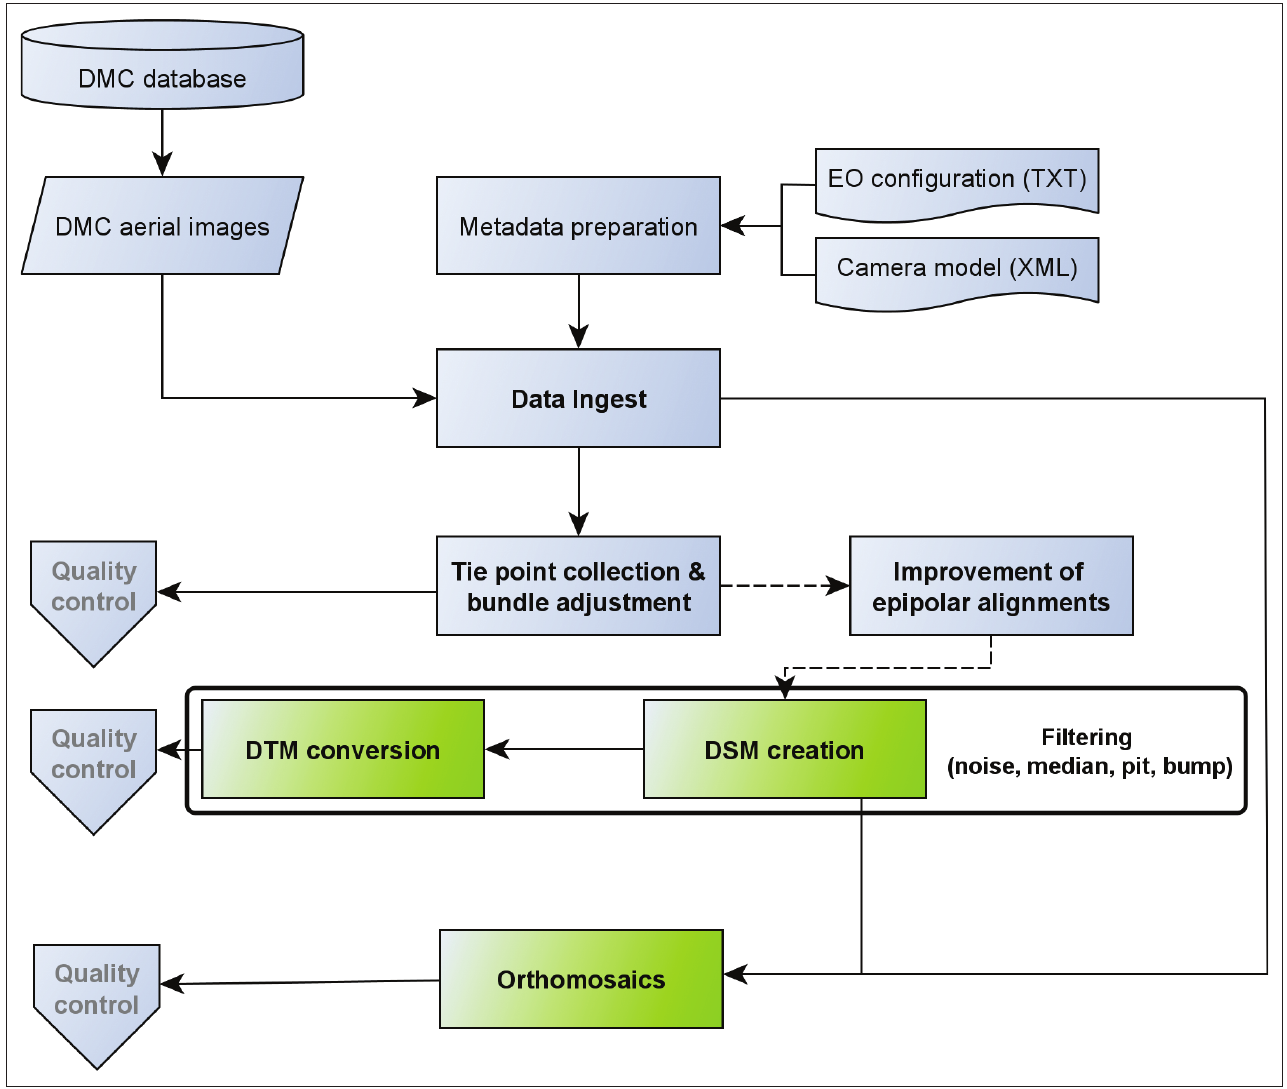
FIGURE 3: Workflow to extract elevation information from digital mapping camera aerial imagery using CATALYST